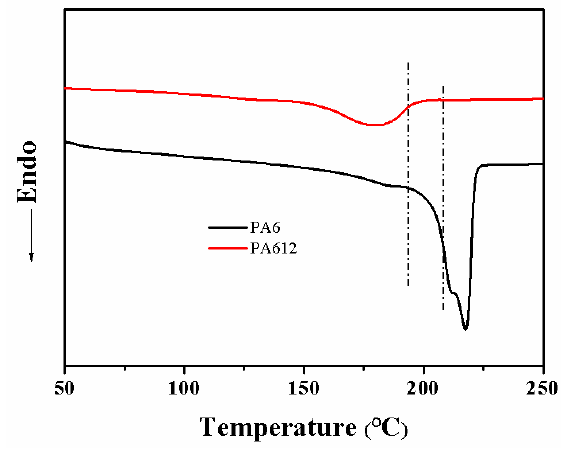
Figure 3. DSC curves (appropriate compression temperature for the formation of a segregated structure, marked) for PA6 microspheres and PA612